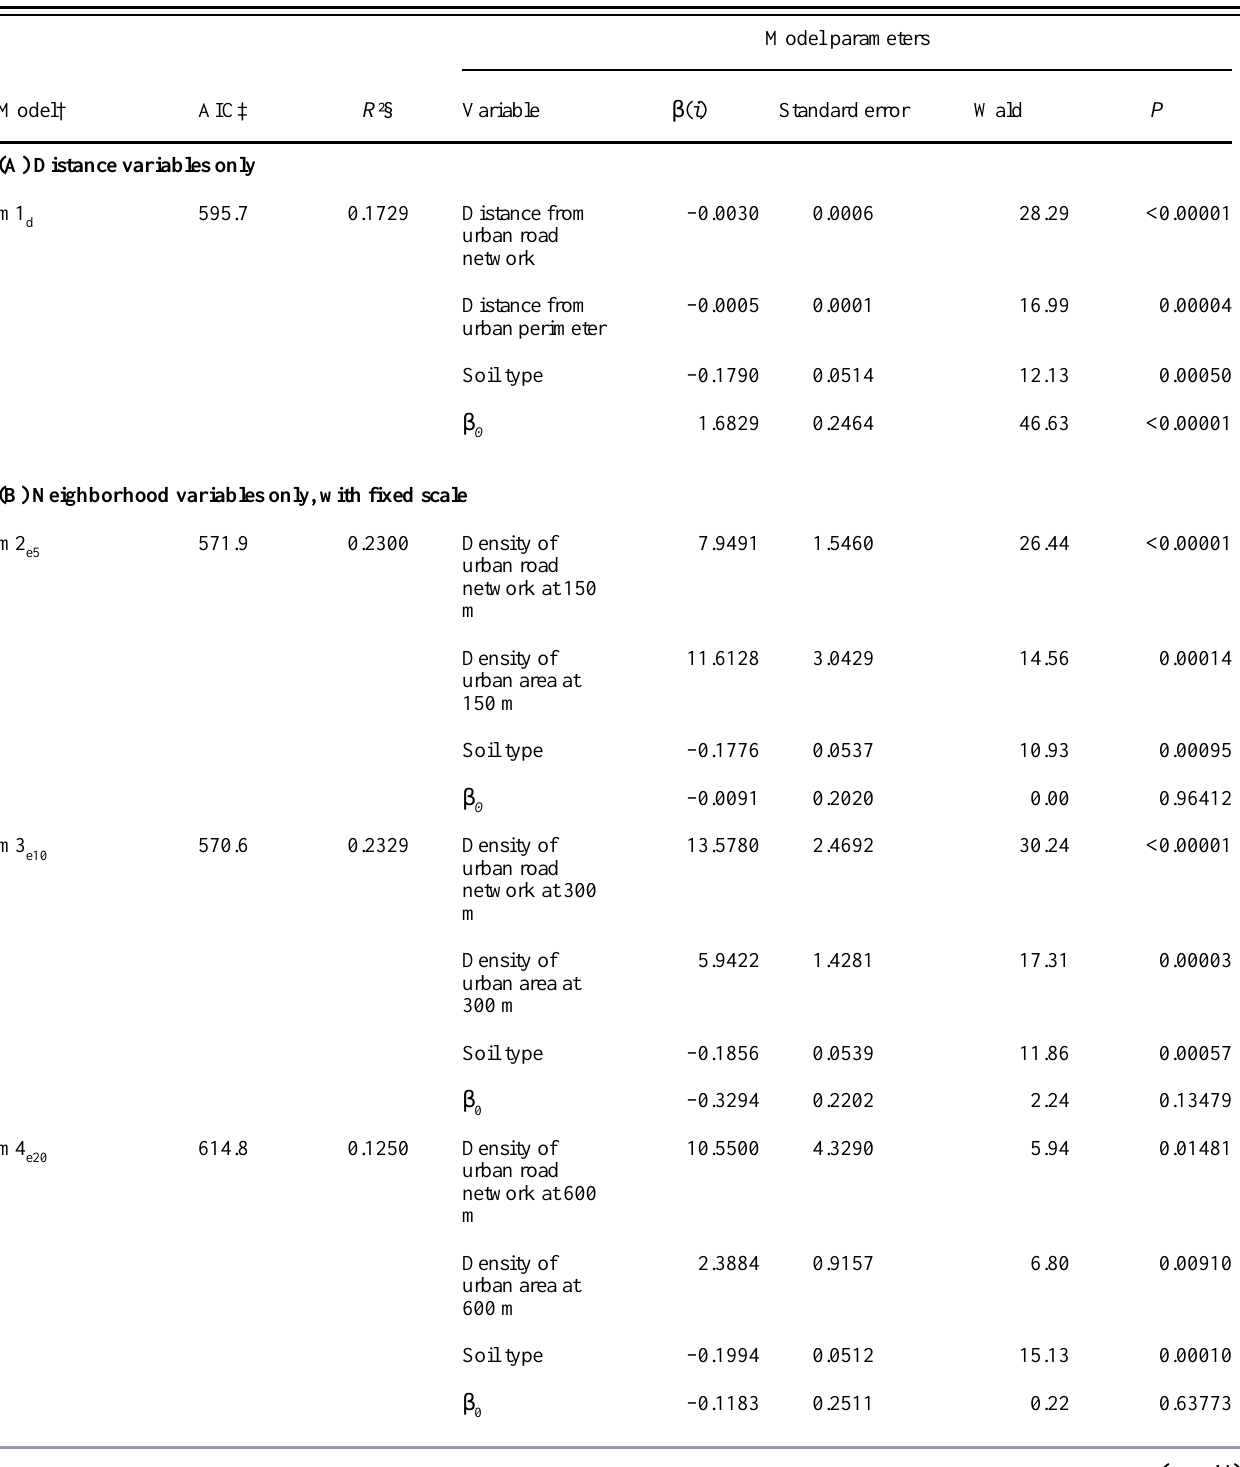
Table 4. Results of the adjustment of the logistic regression using the 500-m random growth model according to variable